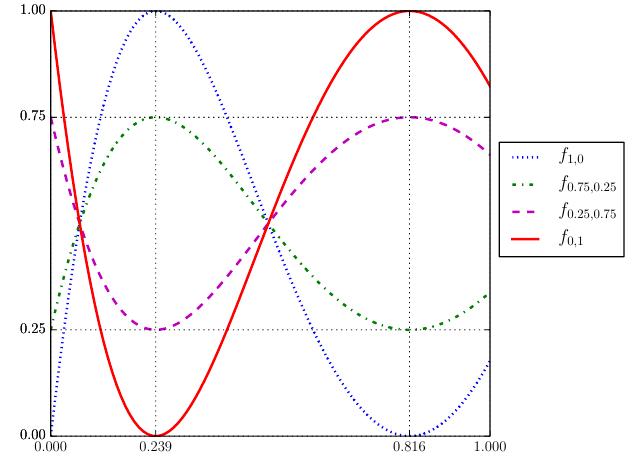
Fig. 2 Graph of the trimodal maps f v